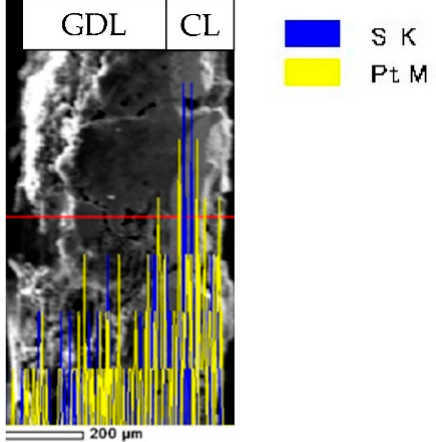
Figure 6. SEM image and EDX analysis on the cross-section of